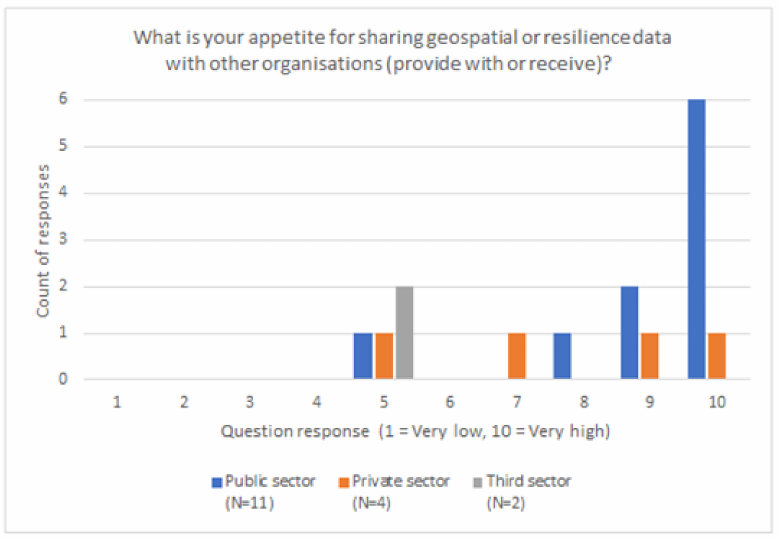
Figure 7. Number of responses per sector obtained for the following survey question: “What is your appetite for sharing geospatial or resilience data with other organisations (provide with or receive)?”. Participants from the third sector were happy to share data with other